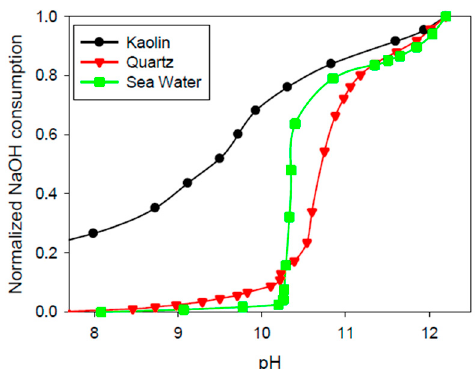
Figure 5. Sodium hydroxide (NaOH) required to modify the pH of (i) seawater, (ii) quartz slurry in seawater and (iii) kaolin slurry in seawater. NaOH is mass (g) consumed per 1 L of solution, normalised by the concentration at pH 12.2 (seawater: 6.1 g/L; quartz: 5.7 g/L; kaolin: 9.1 g/L).